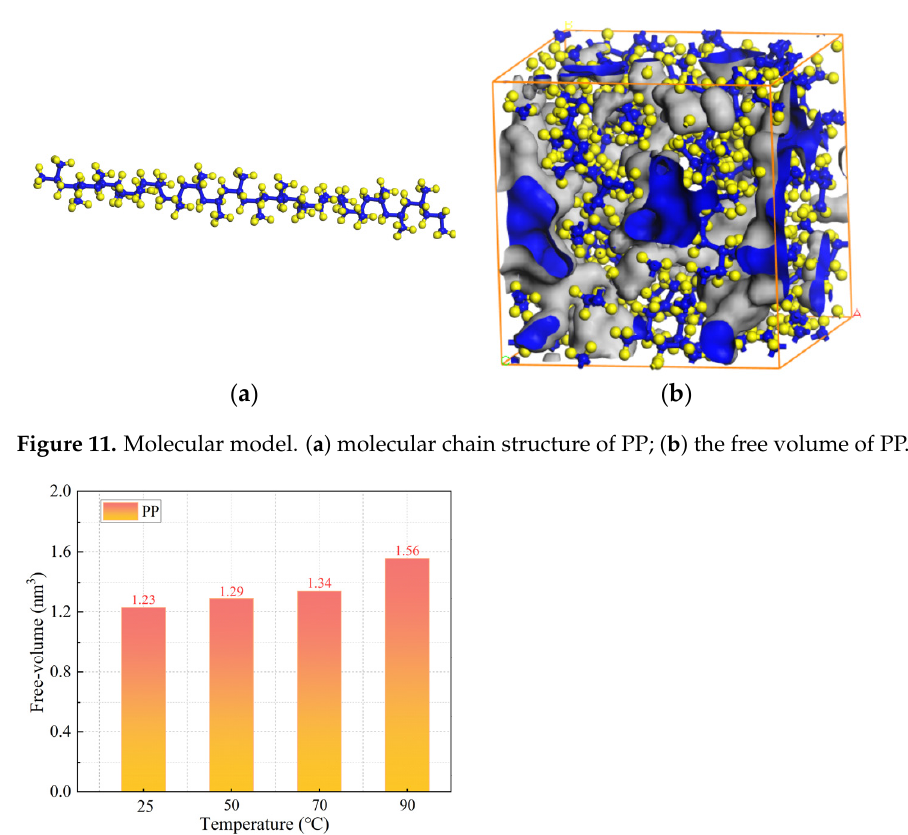
Figure 12. Variation of the free volume of PP with temperature.